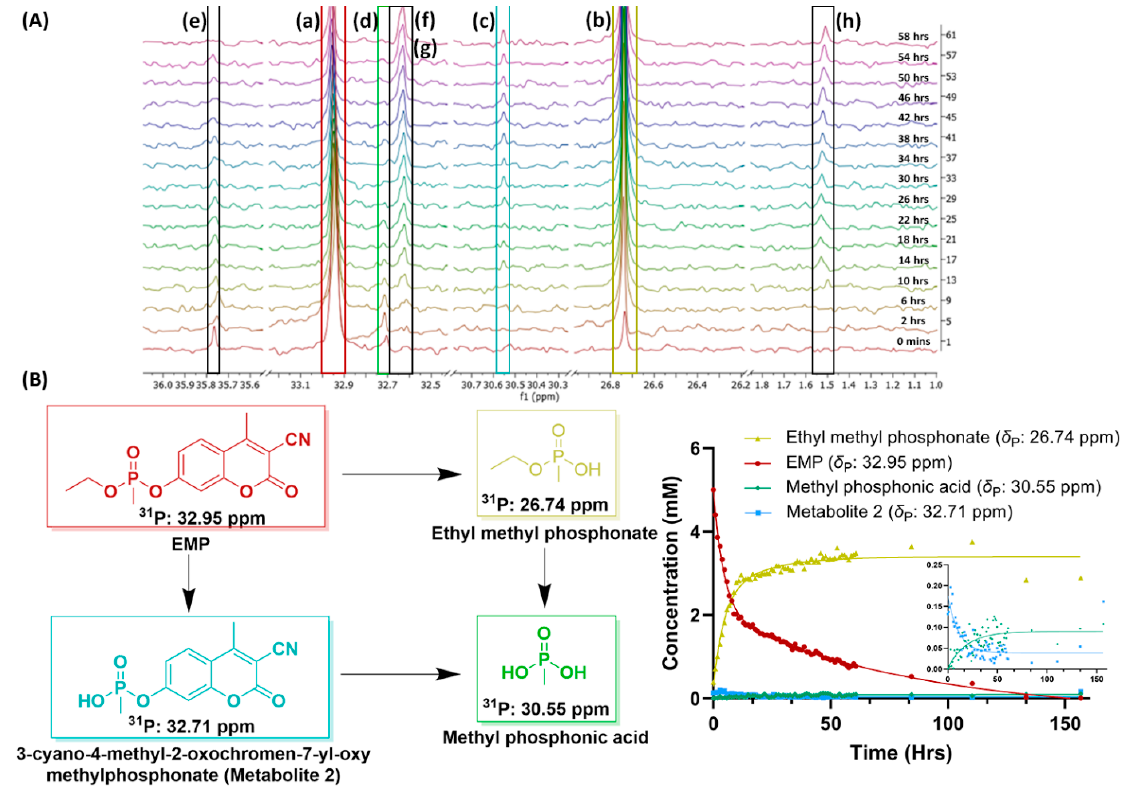
Figure 3. Top Panel: ( A ) Stacked 31 P-NMR spectra of EMP (6) in HLM over a period of 3 days, identifying its metabolites and their chemical shifts; (a) EMP chemical shift, δ P 32.95 ppm; (b) major metabolite of EMP, ethyl methylphosphonate at δ P 26.74 ppm; (c) δ P 30.55 ppm corresponding to methyl phosphonic acid; (d) metabolite of EMP and substrate for CYPs at δ P 32.76 ppm; (e–h) minor metabolites of EMP. Bottom Panel: ( B ) Structures of the major metabolites of EMP (4) in the presence of HLMs identified using 31 P-NMR (in D 2 O; left) and the curves corresponding to the integration of each peak in the 31 P spectrum at each time point (top right) with an expansion of the metabolites with the lowest concentrations (bottom right).